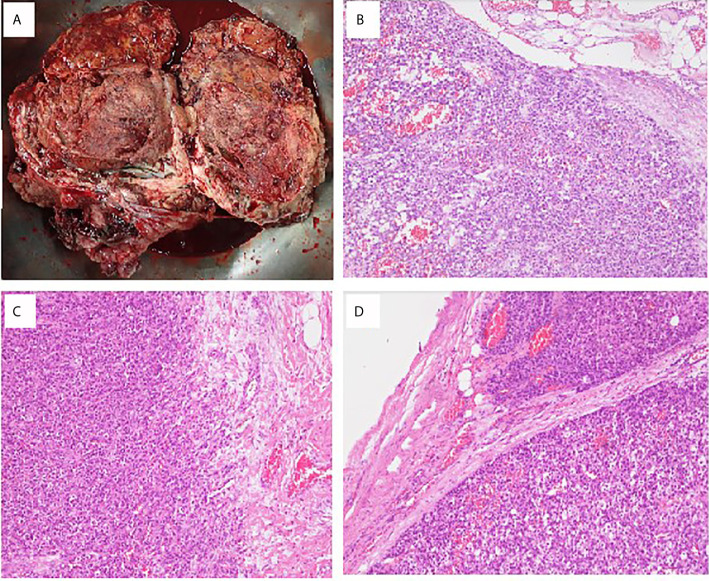
Pathological findings of ovarian adrenocortical carcinoma. (A) A piece of tissue measuring 23 × 17 × 10 cm in size. (B) Sections of the huge ovary and uterine body tumor showing solid sheets and nests of tumor cells with monotonous morphology with large, centrally located nuclei and abundant cytoplasm. Focal tumor necrosis is present. Lymphovascular invasion is prominent. (C) Biopsy sample of the peritoneum cavity. (D) Lymph node metastasis: Lesion cells are arranged in thick trabeculae and in organoid pattern. They contain eosinophilic cytoplasm and small dark nuclei. High prevalence of mitotic figures is seen.